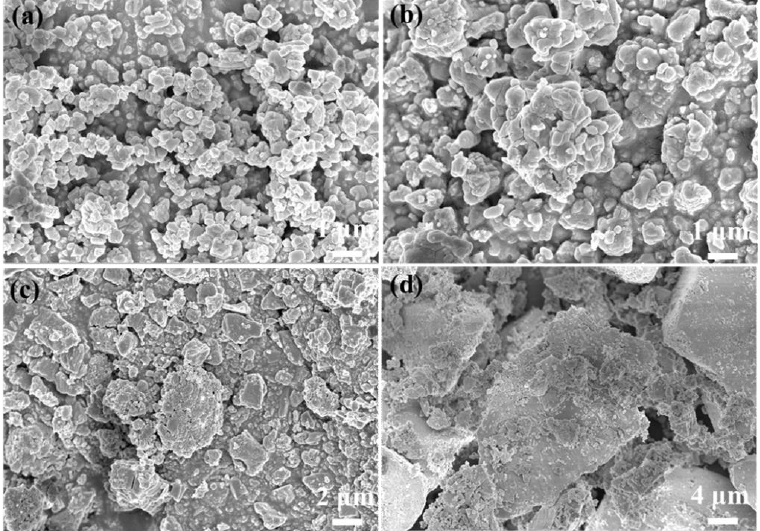
Figure 5. SEM images of ( a ) spent BaF( p −BDC) 0.5 −M500, ( b ) spent BaF( p −BDC) 0.5 −M600, ( c ) spent BaF( p −BDC) 0.5 −M700, ( d ) spent BaF( p −BDC) 0.5 −M800. The scale bar of ( a ), ( b ), ( c ) and ( d ) are 1 μm, 1 μm, 2 μm and 4 μm, respectively.